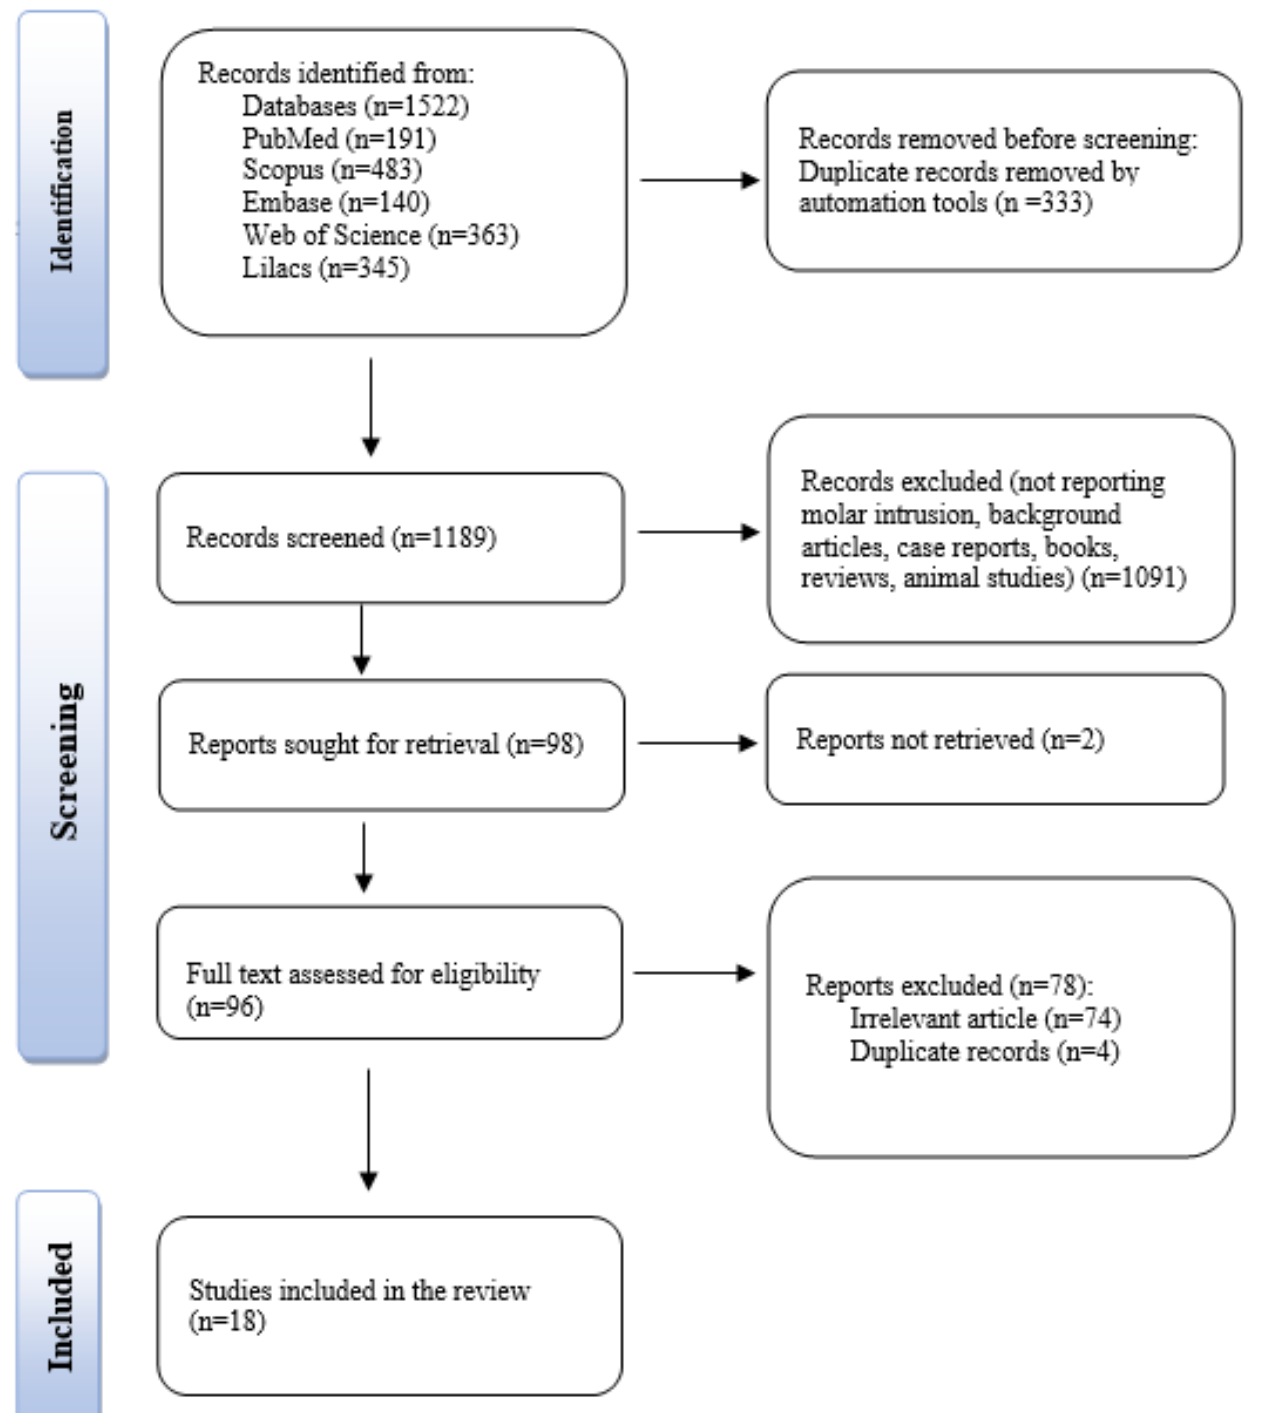
Figure 1. The PRISMA flowchart of the publication